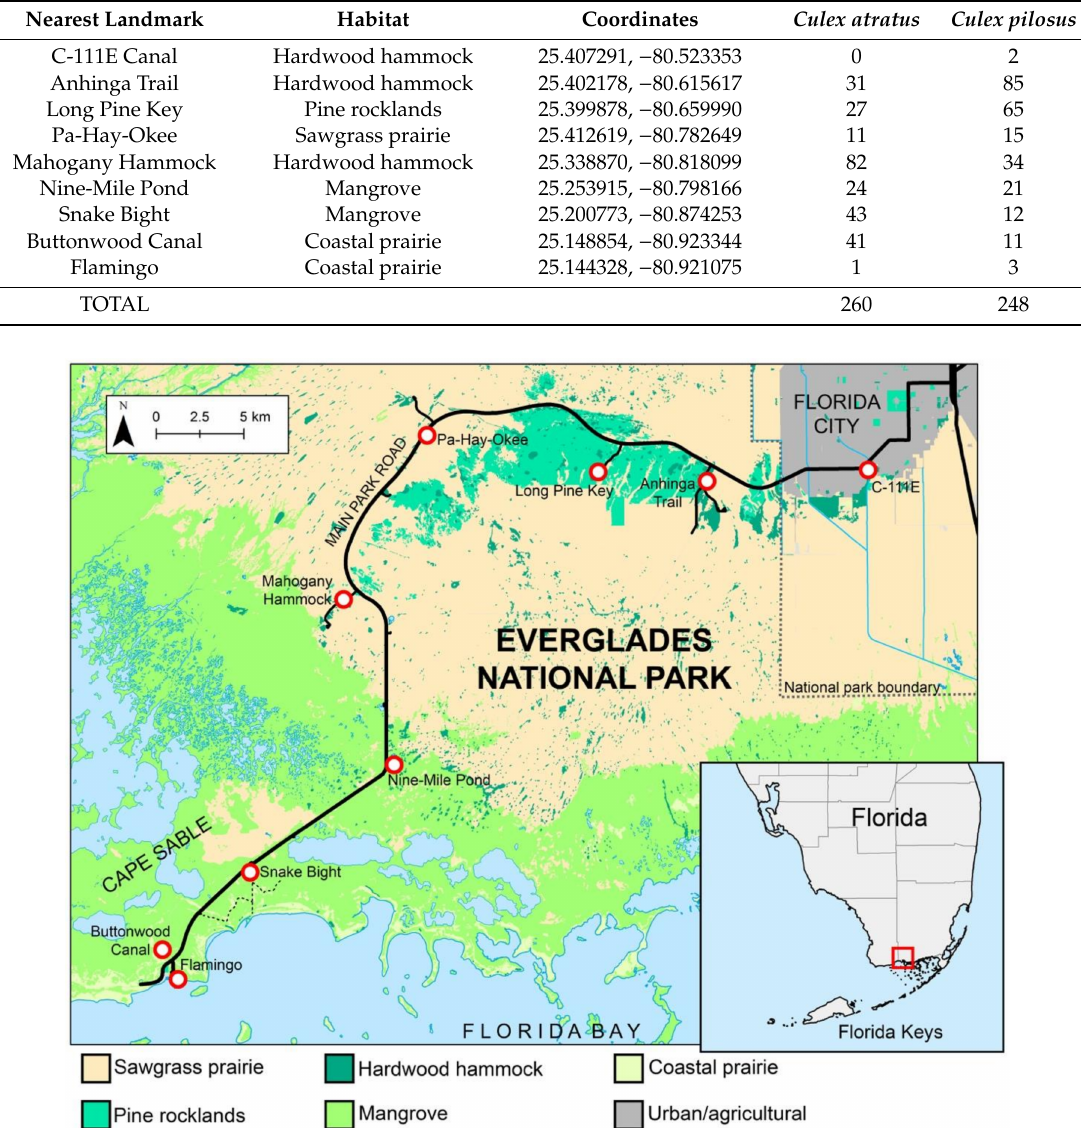
Table 1. Sampling localities in and around Everglades National Park, Florida, United States of America (USA) and number of Culex atratus and Culex pilosus blood meals collected and analyzed from each site. All sites are located within the national park with the exception of C-111E Canal.